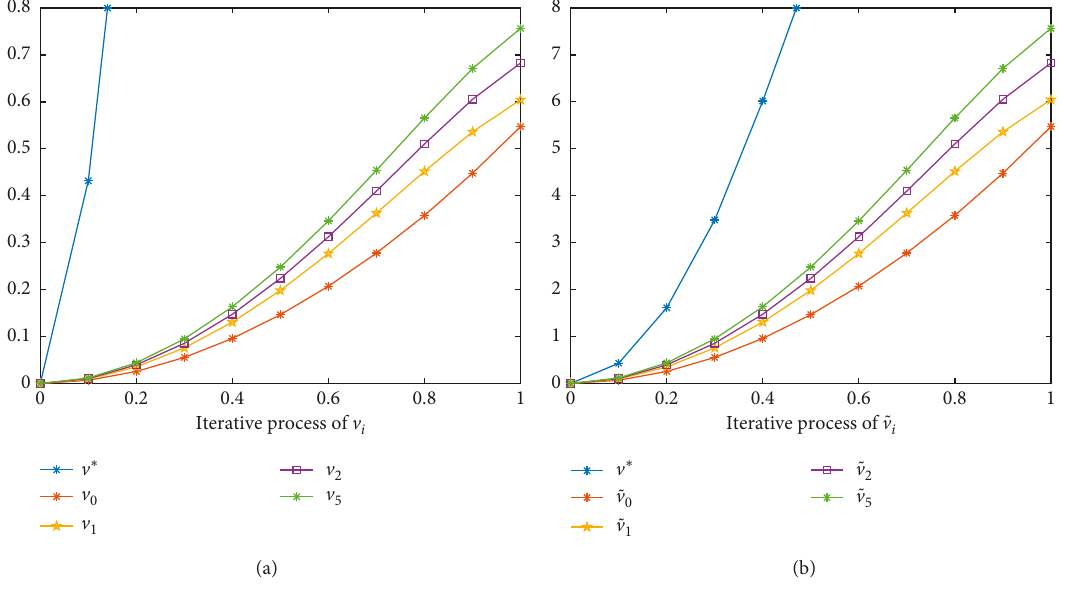
Figure 1: Iterative process of v